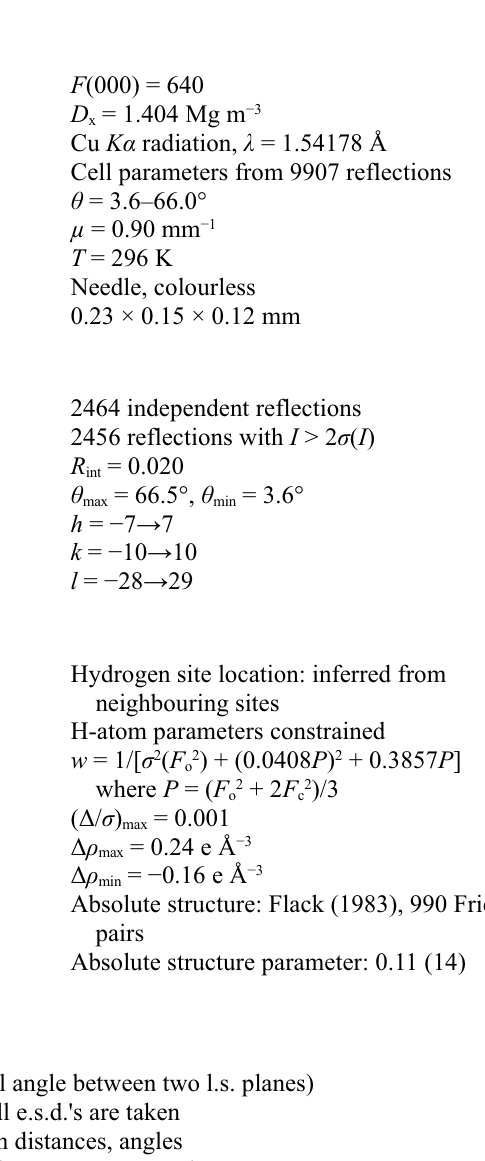
Figure 2 The formation of the title